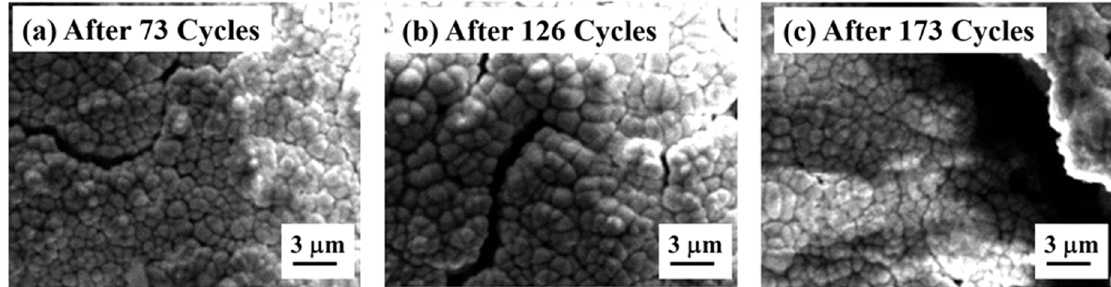
Figure 14. High-magnification SEM images of laser-glazed FG-TBC after ( a ) 73, ( b ) 126, and ( c ) 173 heating–quenching cycles.